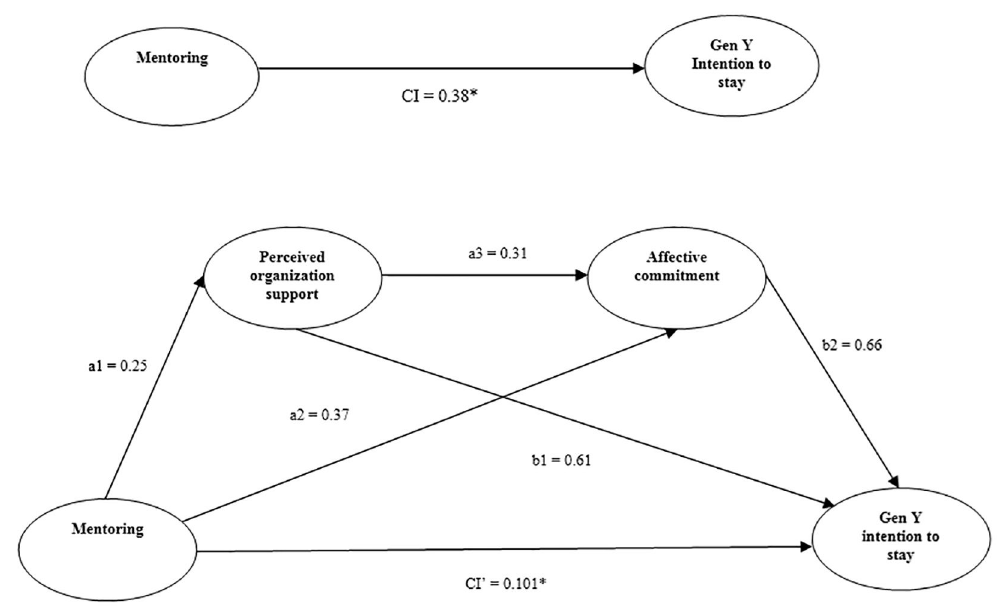
Figure 1. Research model and hypotheses. Note. N = 314. * p < .01. ** p <